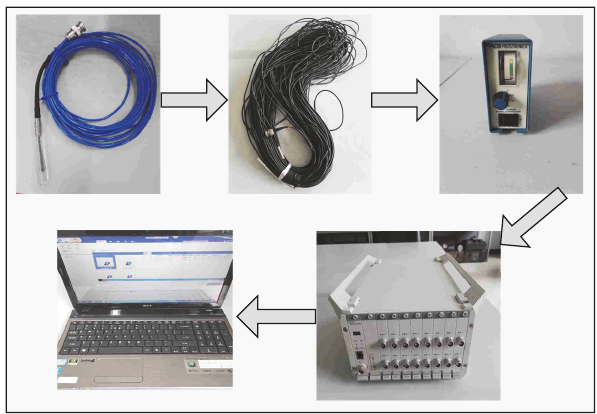
Figure 1: Test system of the shock wave